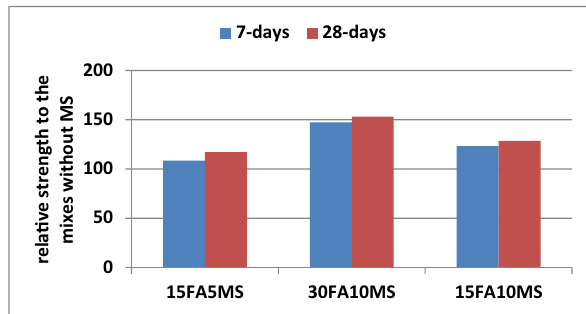
Figure 4: Relative strength of the mixes without MS of